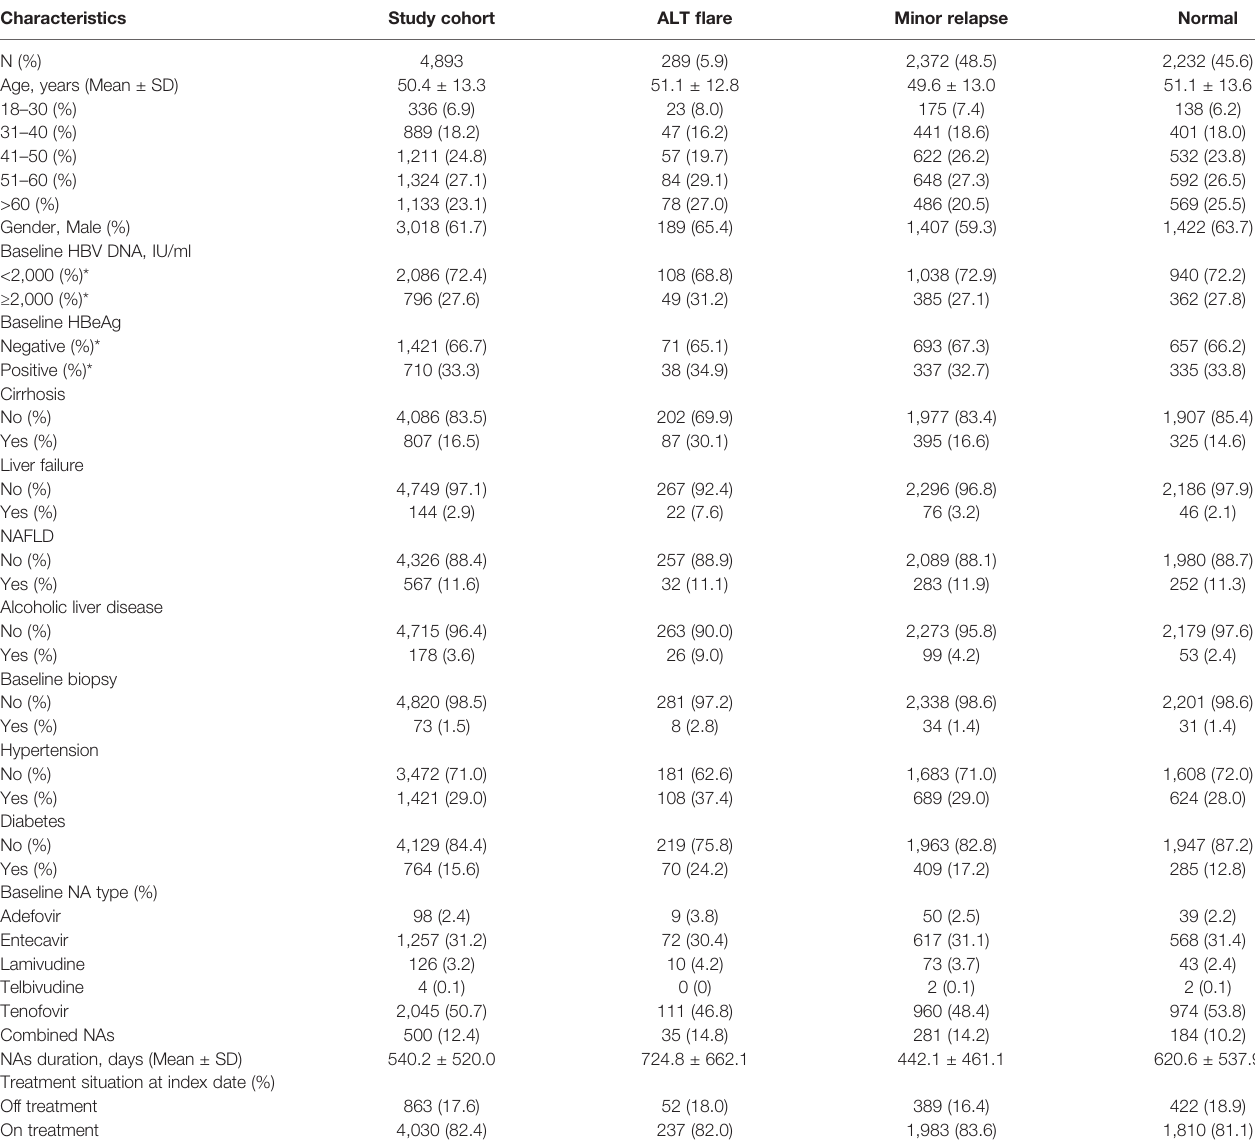
TABLE 4 | Baseline demographic and clinical characteristics of study cohort in the Optum EHR database, the US.